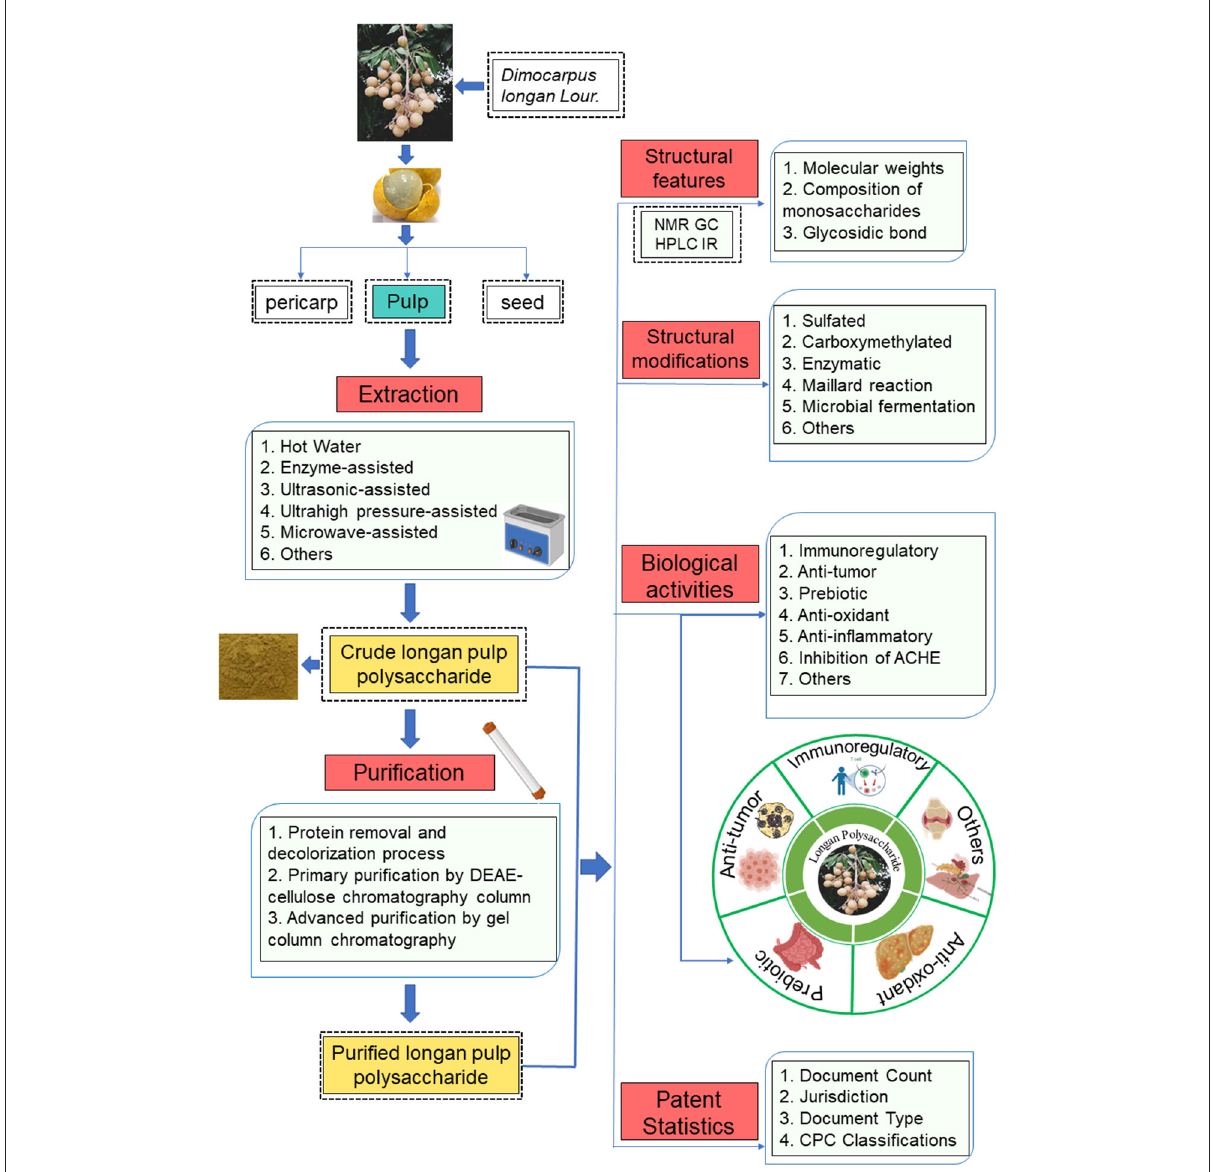
FIGURE2 Schematic diagram of extraction, purification, basic structure, structural modification, biological activity and patent statistics of